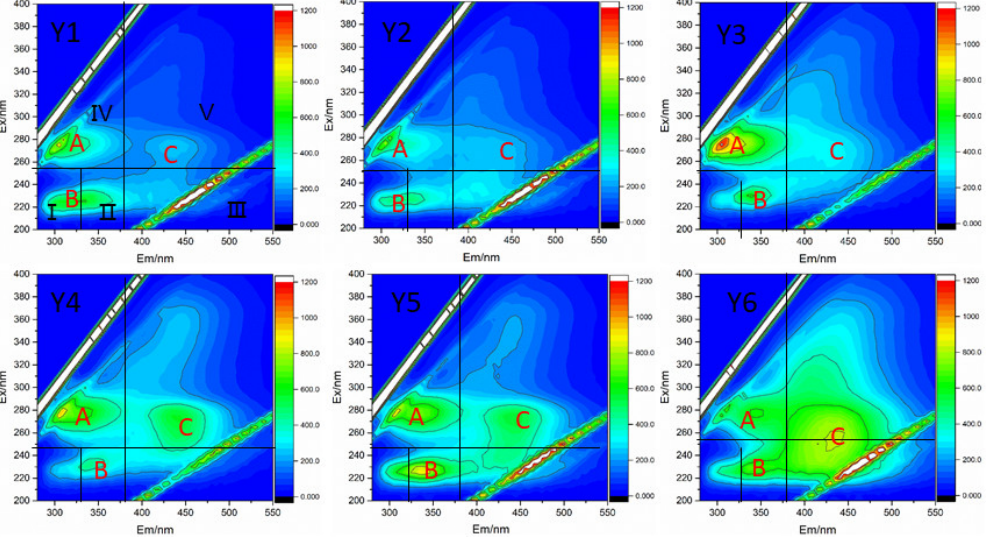
Figure 6. 3D fluorescence maps of DON from each sample site.